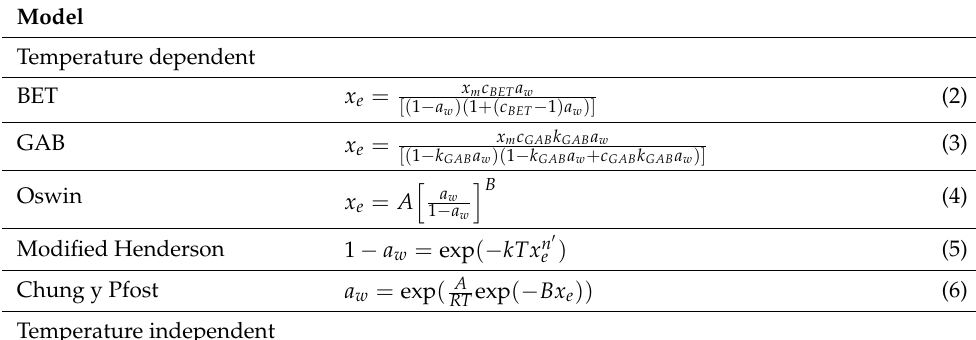
Table 2. Mathematical models of the adsorption isotherm.